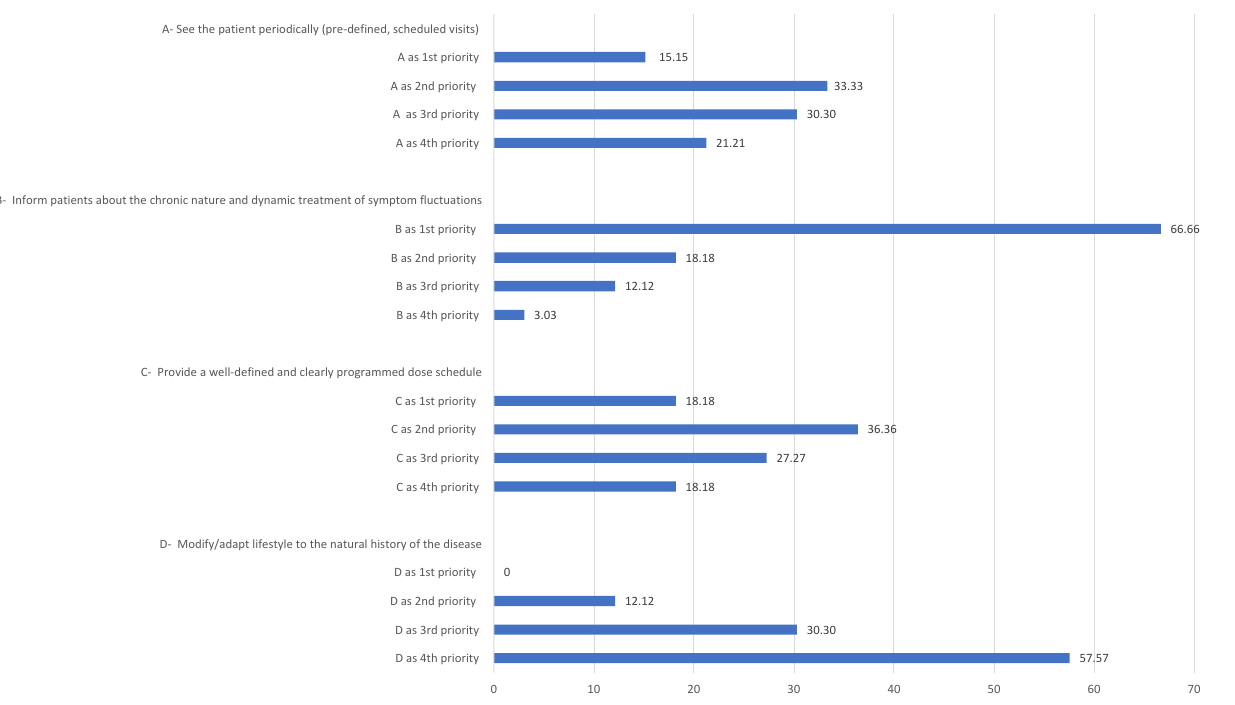
Figure 1. The ranking of the priorities attributed to the two statements related to managing dry eye disease and inflammation over